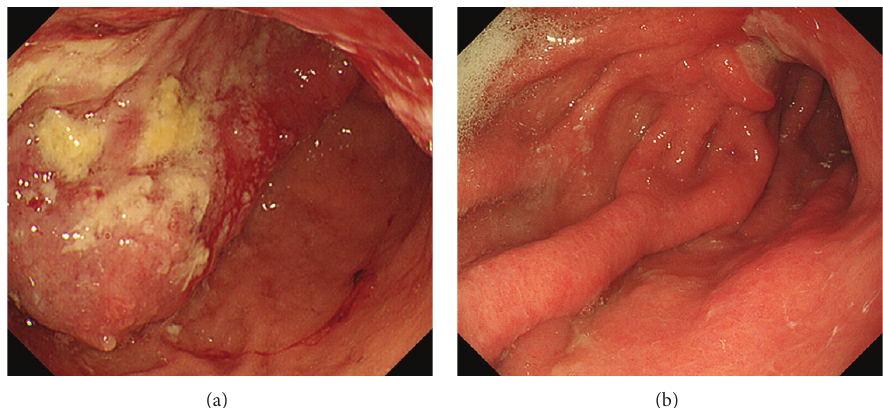
Figure 1: Endoscopic findings. (a) Gastroscopy at presentation revealed an ulcerative mass with raised margins along the lesser curvature extending from the lower body of the stomach to the antrum. (b) After completion of the 11th course of chemotherapy (capecitabine + CDDP + trastuzumab), the gastric tumor is decreased